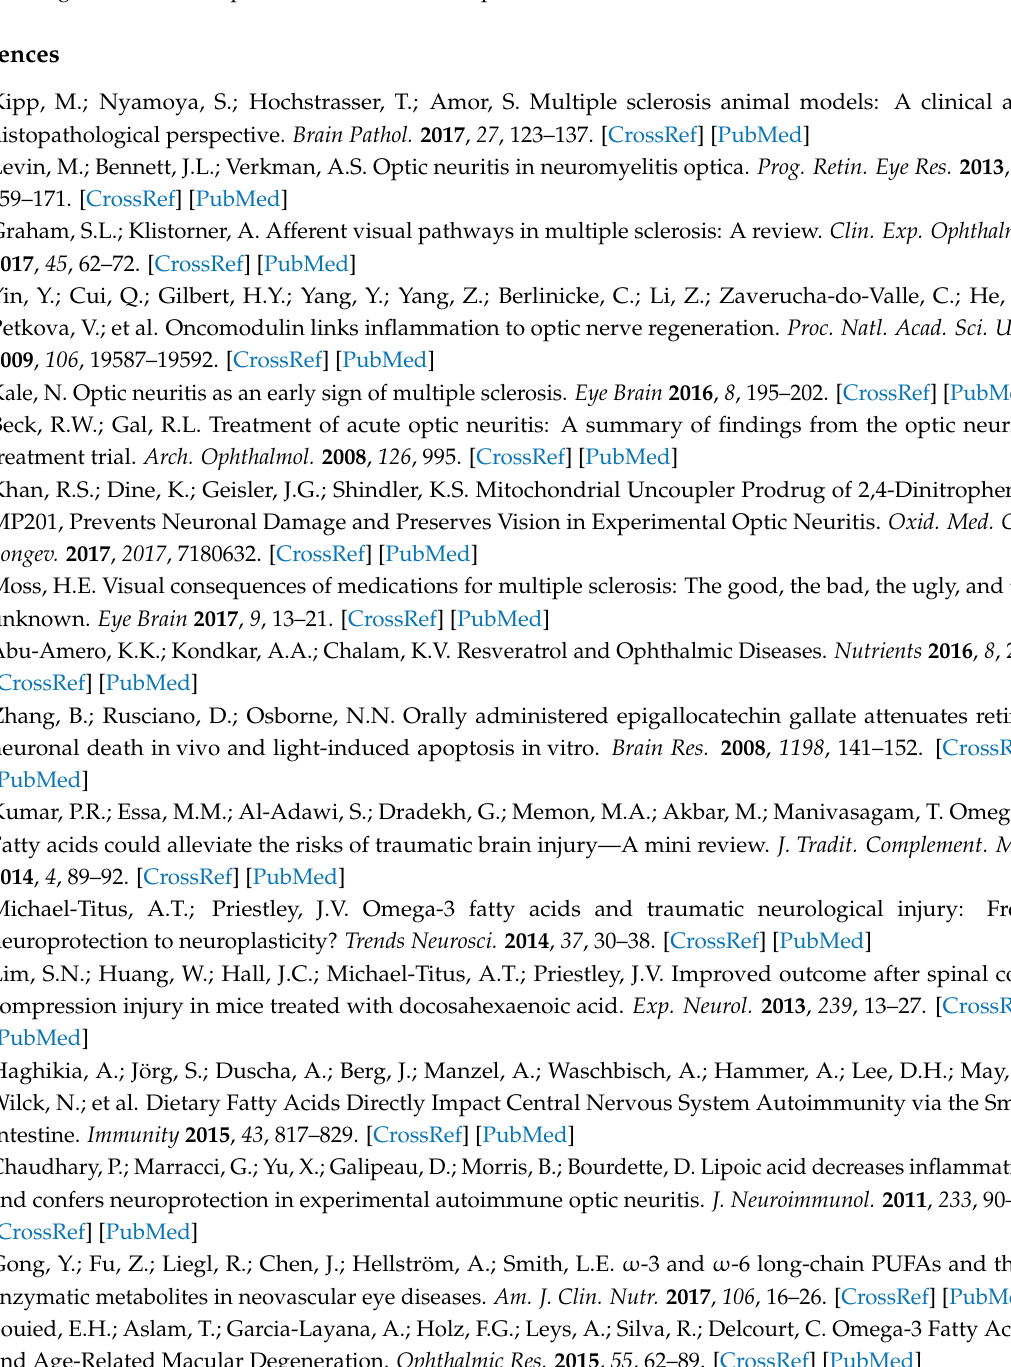
Table S1: Sequences of primer sets used for qPCR